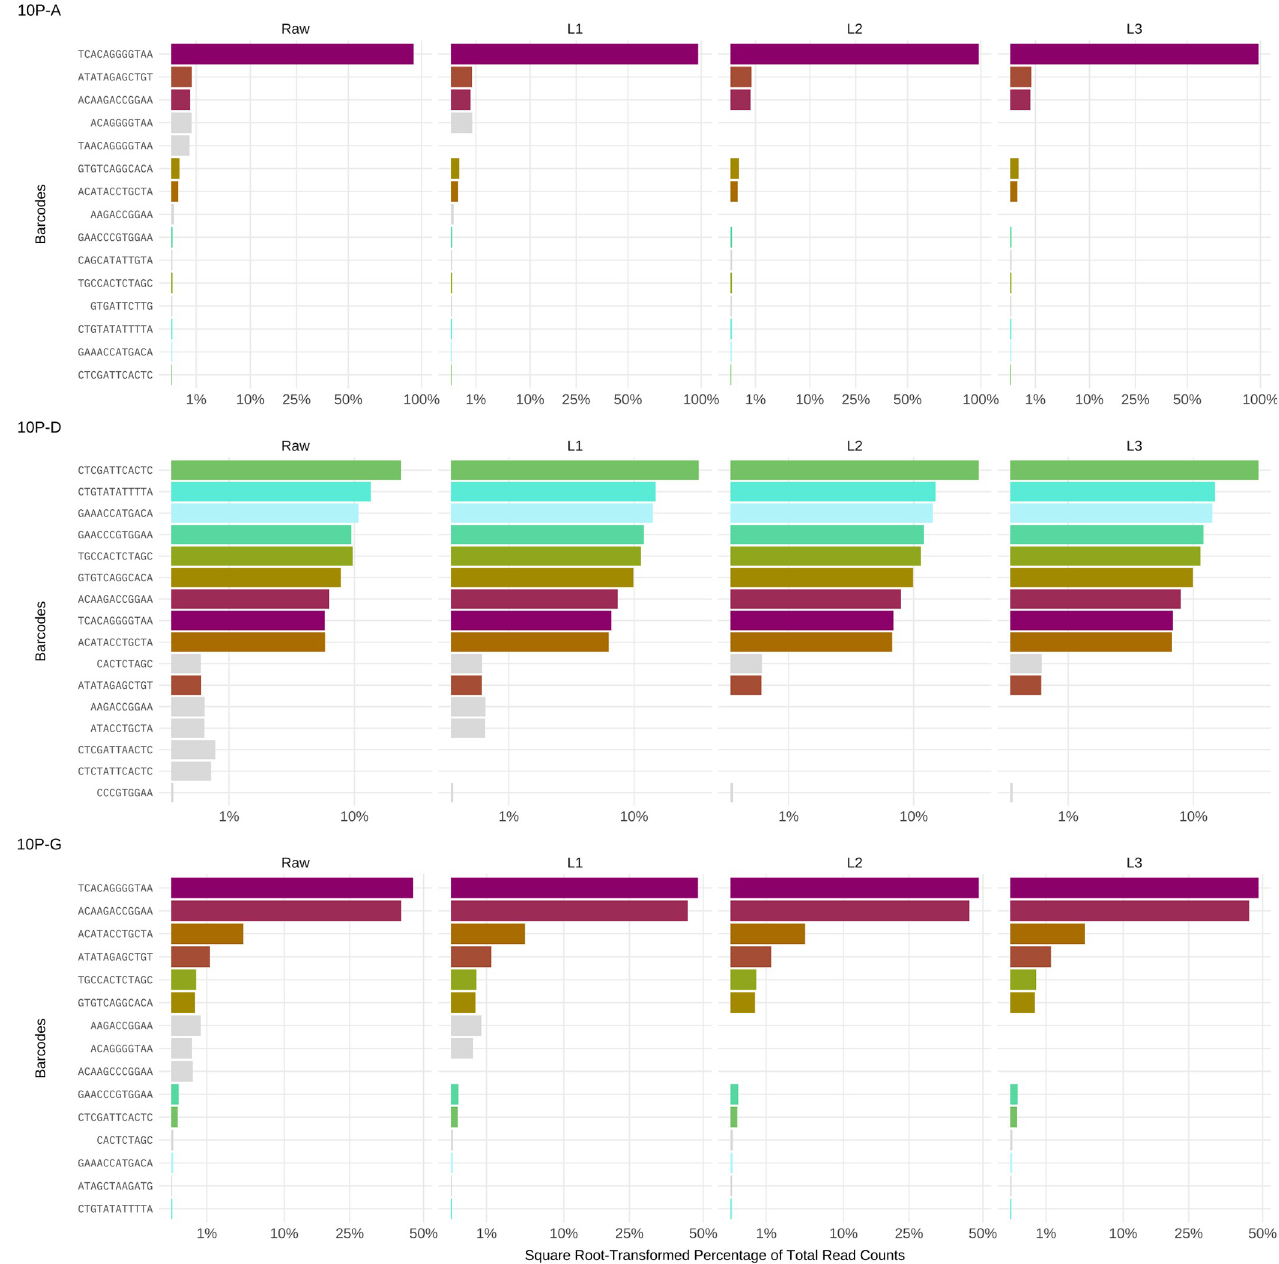
Fig 3. Illumina sequencing reads from 10-plasmid controls using different clustering distances. The y-axis depicts the barcode sequence; the x-axis shows the square root-transformed percentage of total read counts. The colored bars represent the control barcodes. Gray bars represent the most common erroneous barcodes within a library. The plots compare the raw percentages (no clustering) with clustering using Starcode’s message-passing algorithm, and L = 1, L = 2, and L = 3 distance parameters. Here we show the 10-plasmid controls 10P-A, 10P-D and 10P-G. Additional 10-plasmid controls are shown in S4 Fig.